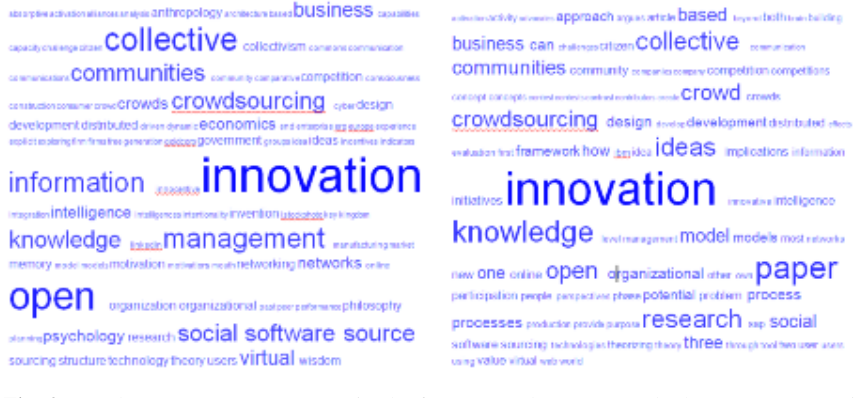
Fig. 3. Word Frequency Maps (Tag Clouds) for Keywords (LEFT) and Abstracts (RIGHT) in Our